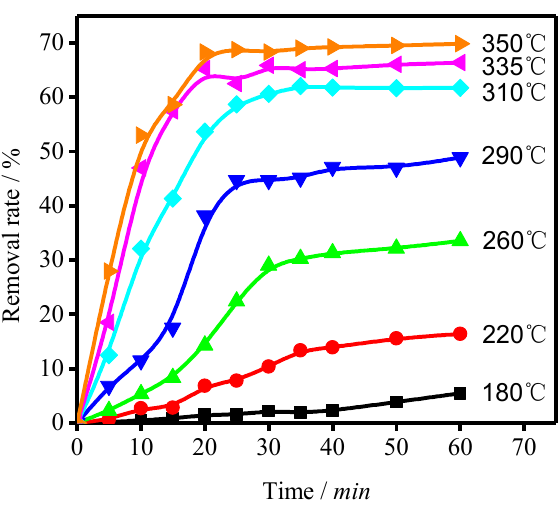
Figure 4: Effect of temperature on iron removal rates with time . Figure 4. Effect of temperature on iron removal rates with time